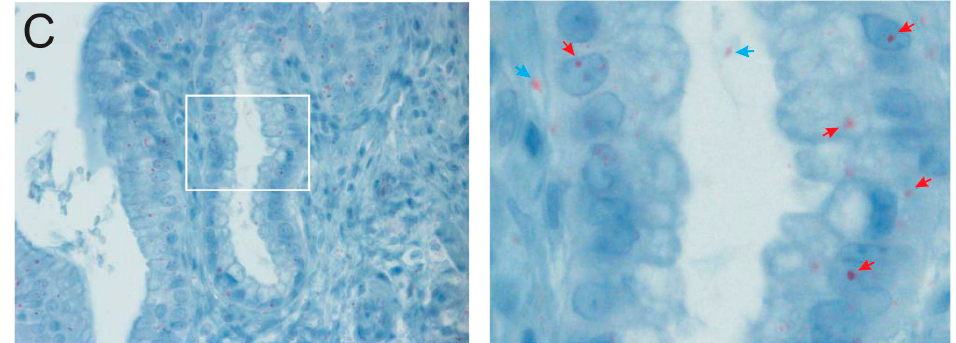
Figure 2. Histological sections from the gallbladder of the patient. The magnification is 40 × for the left panels, and a 200 × magnification of the identified section (white box) is shown to the right. ( A ) Identification of collagen-rich fibrosis using hematoxylin–eosin staining and mucosal cholesteatosis. Very focal active inflammatory infiltrates are present; ( B ) Warthin–Starry silver staining of the section shown in panel A inside the white square; ( C ) Immunohistochemistry using a monoclonal antibody against Helicobacter pylori showing red, partly intracellular positive signals. In the right panel, H. pylori- like spiral shaped bacteria of approximately 2–3 µ m in length are visible (blue arrows). Coccoid bacteria with up to 1 µ m in diameter are also present (red arrows).